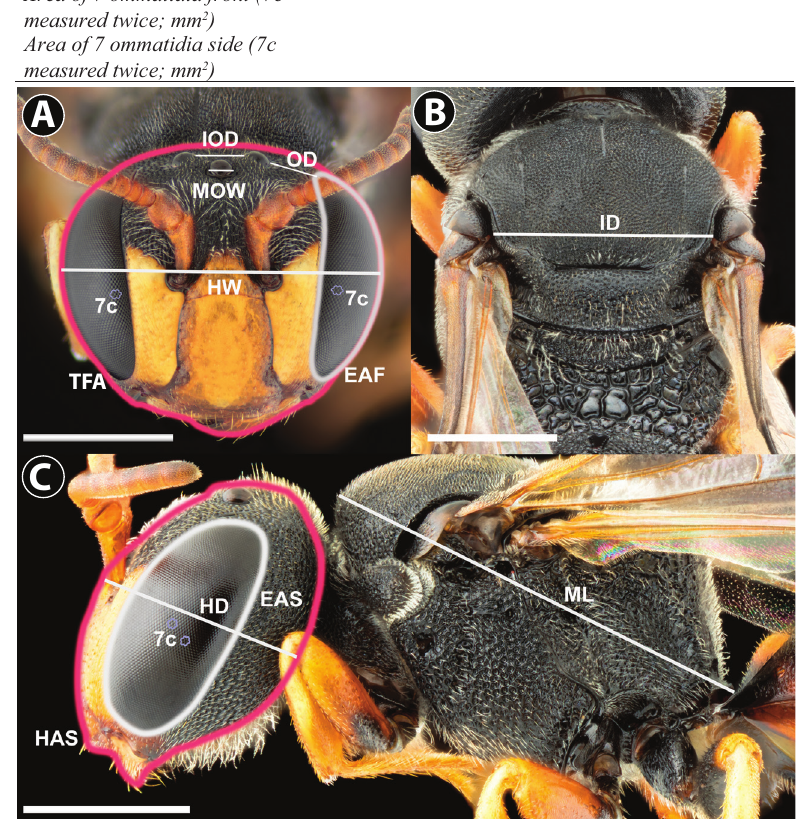
Figure 1. Morphology measures taken from A frontal; inter-ocellar distance (IOD), ocello-ocular dis- tance (OD), median ocellus width (MOW), head width (HW), the area of seven ommatidia twice (7c), eye area front times two (EAF), total face area (TFA) B above; intertegular distance (ID) and C laterally; head area side (HAS), the area of seven ommatidia twice (7c), head depth (HD), eye area (EAS) and meso- soma length (ML). Bars are 1 mm in length. Italicised direct measures are those that were not included in the final analyses. Example species is the diurnal Hylaeus ( Hylaeteron ) hemirhodus (Colletidae: